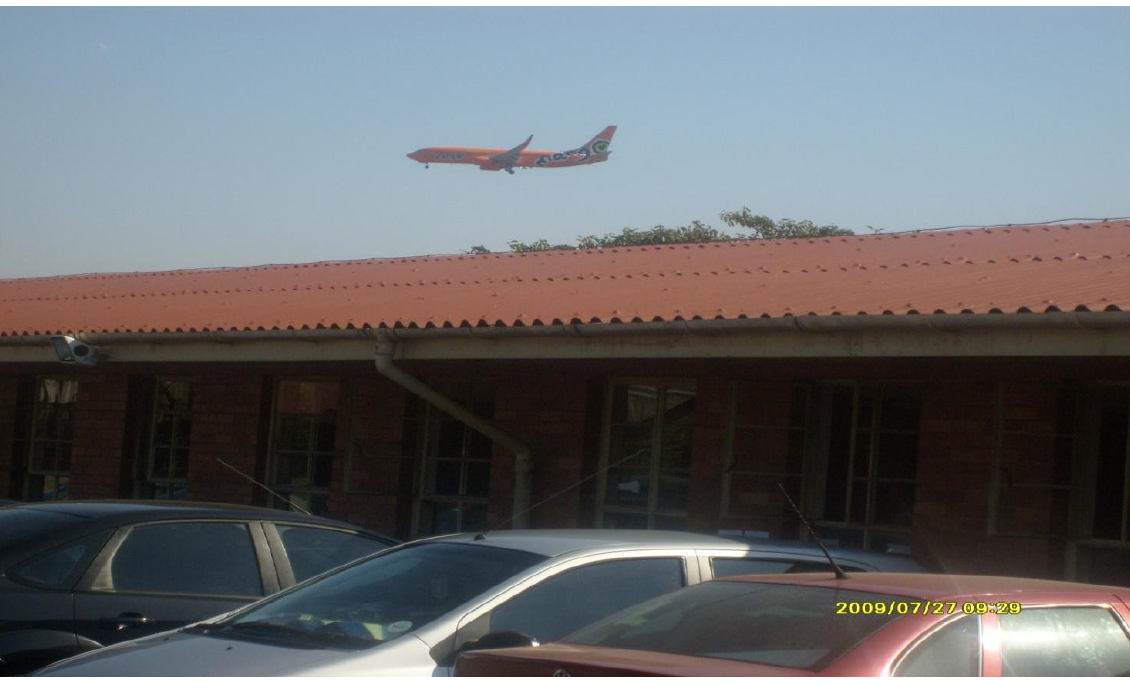
Figure 2. A sample of an aircraft flying over a